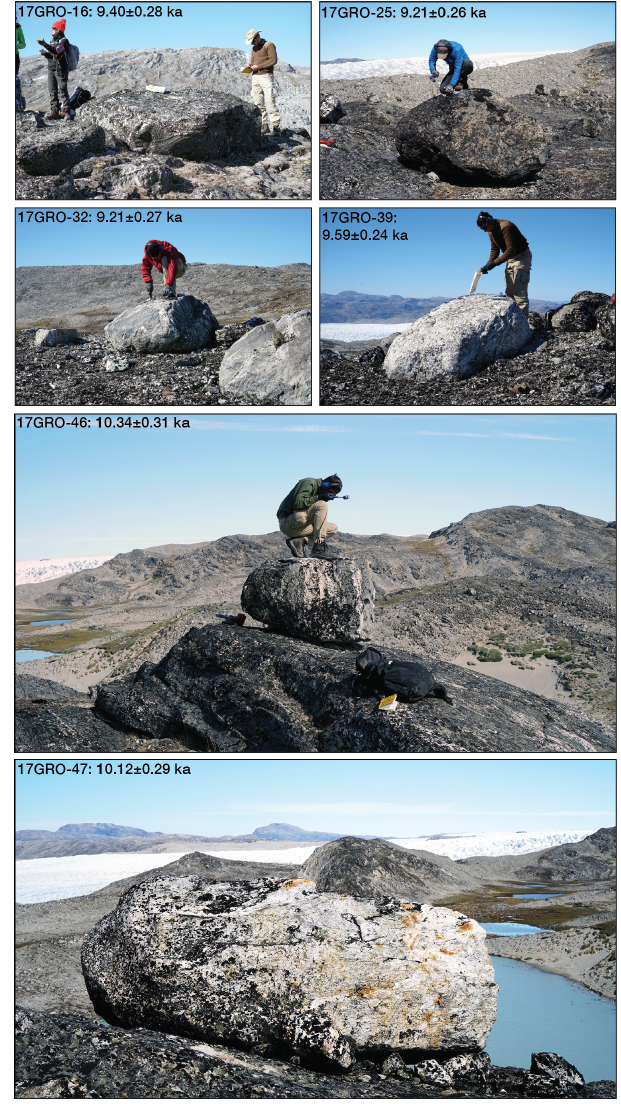
Figure 5. Representative boulder samples from the Qamanaar- suup Sermia region (Fig. 3). Samples 17GRO-16, 17GRO-32, and 17GRO-39 are moraine boulder samples. 17GRO-25 is an erratic boulder perched on bedrock inside the Kapisigdlit stade moraine located only a few meters outboard of the historical maximum moraine, which can be seen in the background. Samples 17GRO- 46 and 17GRO-47 are erratic boulders resting on bedrock located outboard of the Kapisigdlit stade